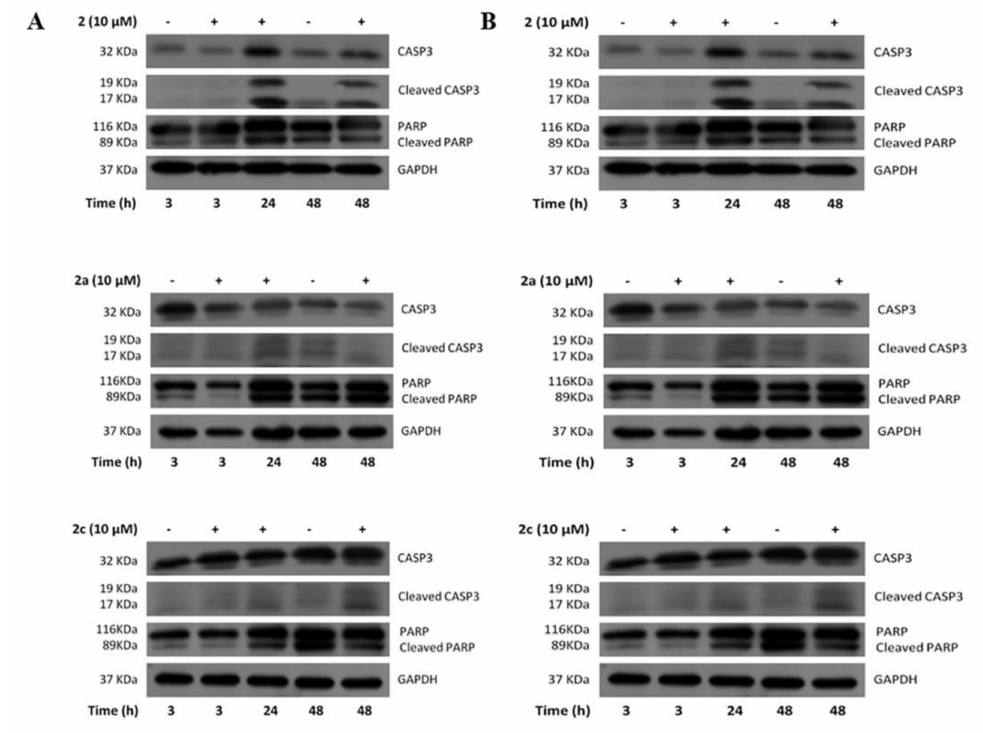
Figure 6. Western blots analysis of caspase-3 and PARP expression performed in DLD-1 cells ( A ) and HCT116 ( B ) treated with compounds 2 , 2a and 2c . The apoptotic process was activated by treatment with these three